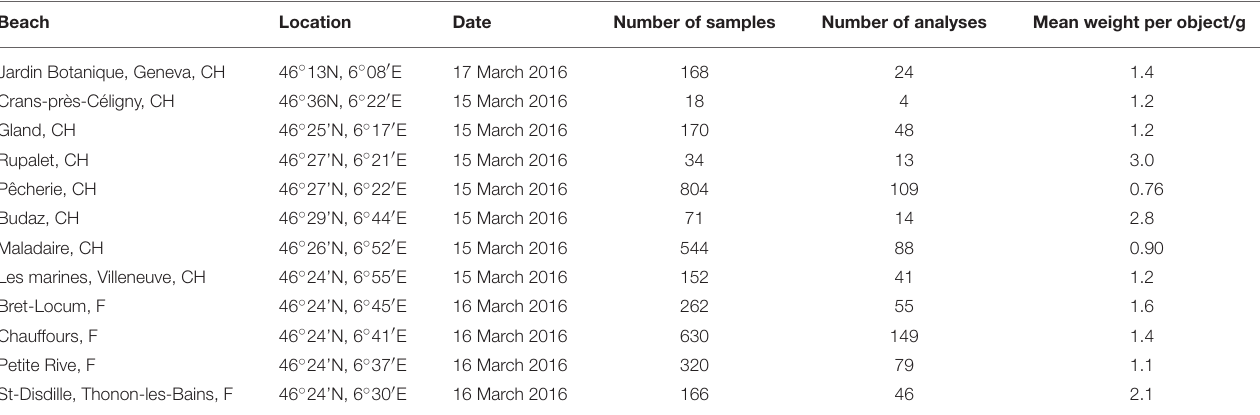
TABLE 1 | Name and location of each beach and information about the number (and average weight) of samples retrieved and the number of XRF analyses performed. Beach Location Date Number of samples Number of analyses Mean weight per